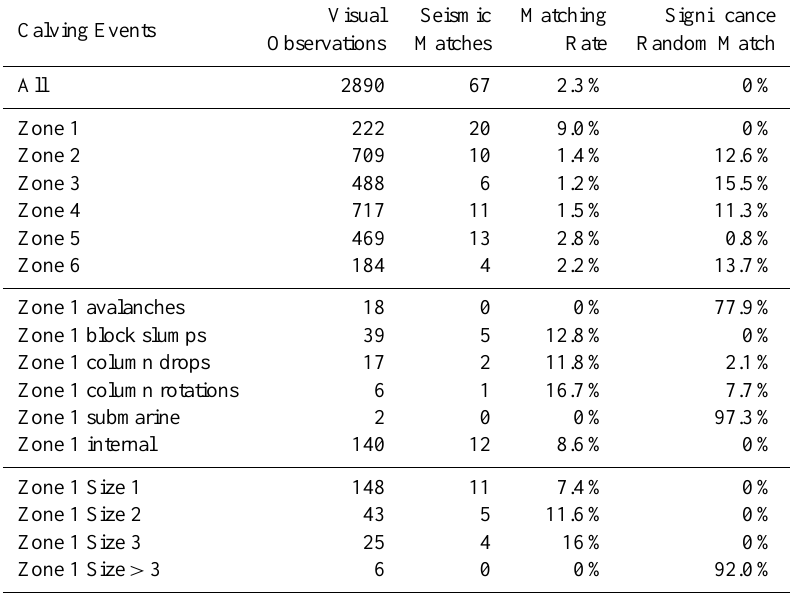
Table 1. Results of matching seismic detections and visually observed calving events for 11 days. “All” means that all observations are used including a number of 101 not assigned to one of the 6 zones. “Matching Rate” is percentage of visual observations that can be related to seismic detections. “Significance Random Match” refers to binomial test for statistical significance of matches. It is probability that matches can be produced by chance. Visual Seismic Matching Significance Calving Events Observations Matches Rate Random Match All 2890 67 2.3% 0% Zone 1